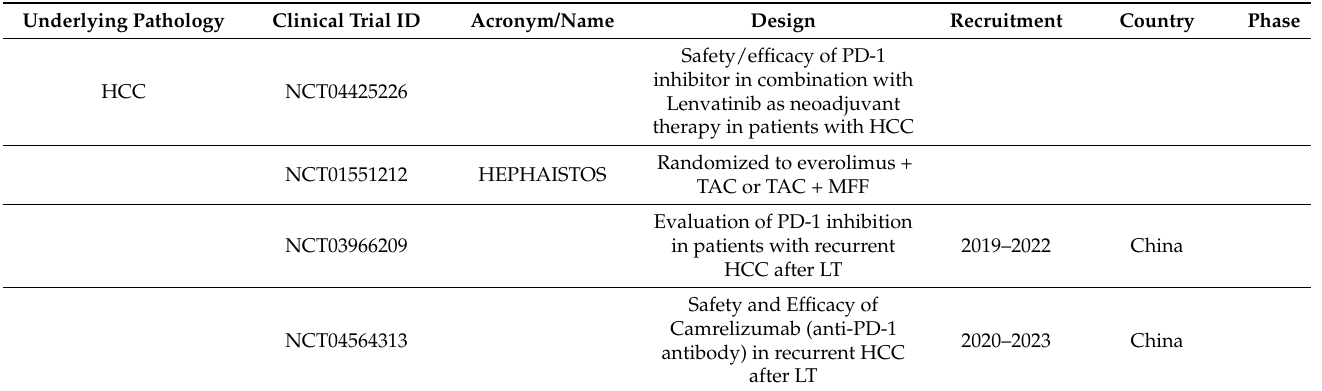
Table 2. Bridging and immunotherapies in LT—ongoing